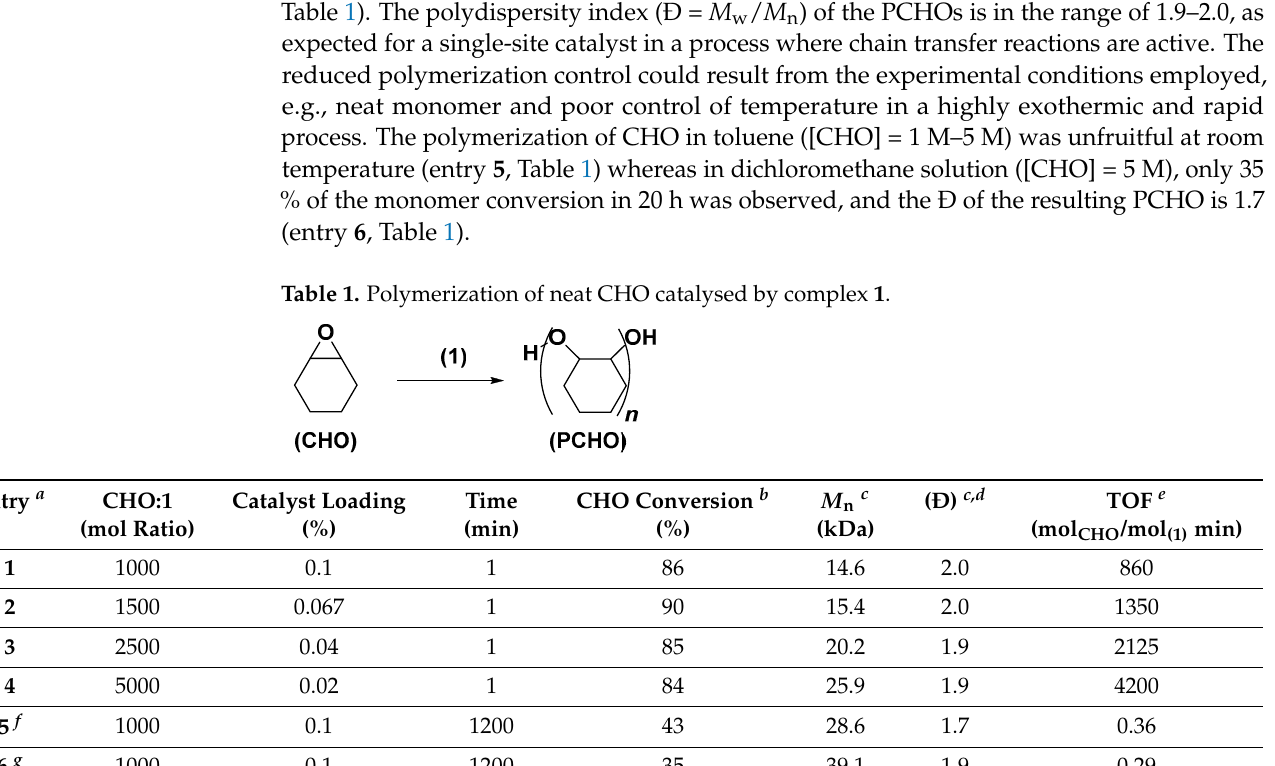
Figure 1. 1 H NMR spectrum of PCHO (600 MHz, C 6 D 6 , 25 °C) (entry 5 of Table 1) with the signals for the isotactic ( mm ), heterotactic ( mr and rm ) and syndiotactic ( rr ) triads